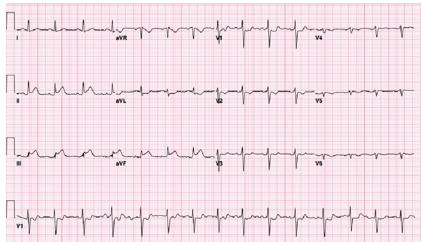
Figure 2: Electrocardiogram following cardiac catheterization and balloon angioplasty, showing resolution of inferior